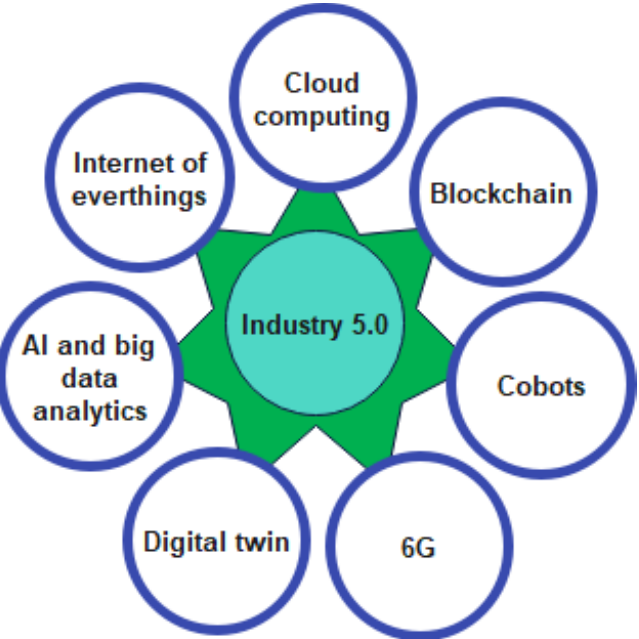
Figure 3. Enabling technologies of Industry 5.0.